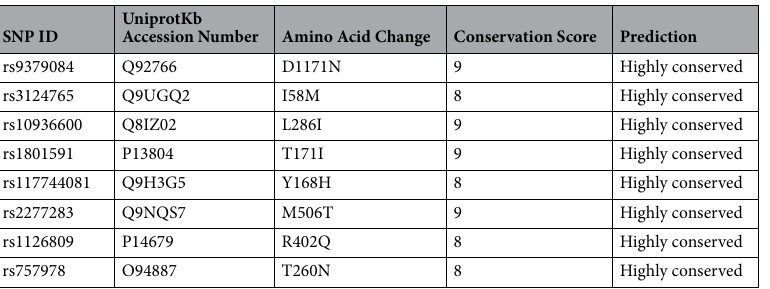
Table 4. Conservation profile of amino acids in proteins with high-risk nsSNPs by ConSurf. 1 ≤ conservation score ≤ 4 = variable, 5 ≤ conservation score ≤ 6 = intermediate, and 7 ≤ conservation score ≤ 9 = highly conserved.